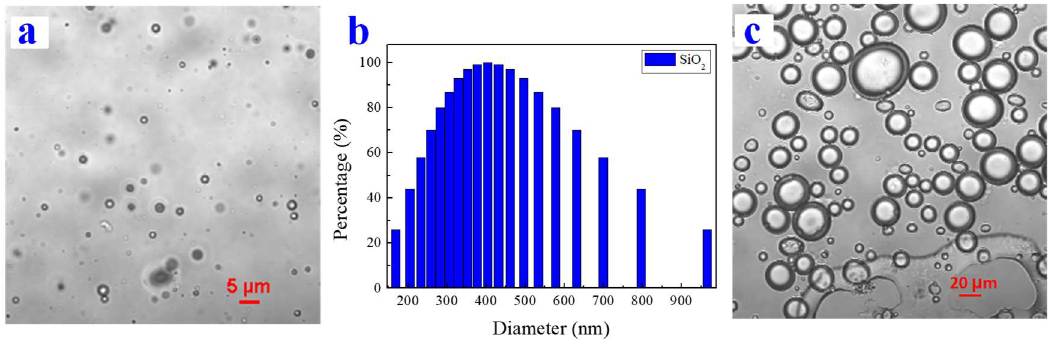
Figure 3. ( a ) Optical image of SiO 2 NPs; ( b ) DLS measurement for size distribution; and ( c ) an optical image of emulsion droplets after locating the silica NPs at the interface.